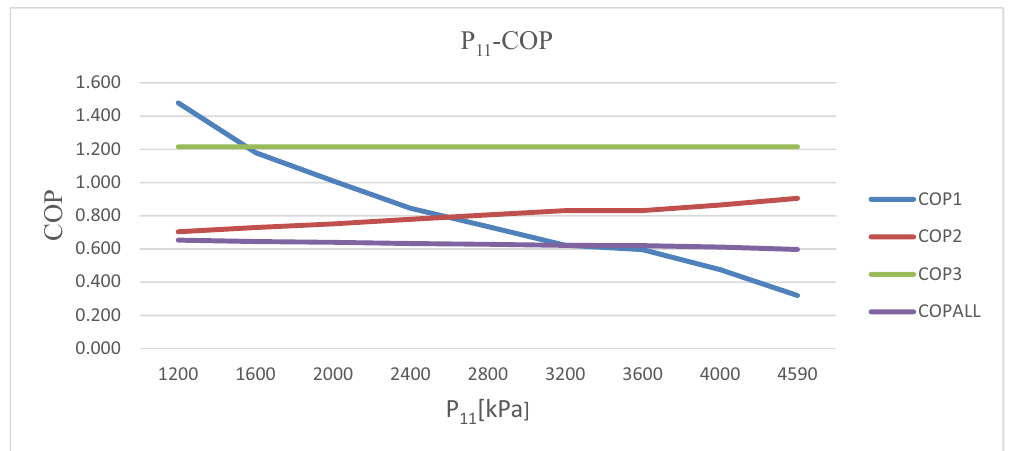
Figure 7: COP 1 , COP 2 , COP 3 , and COP all curves of the whole cycle obtained for di ff erent outlet pressures at which the fi rst - stage compressor of the vapor compression three - stage cascade cryogenic cycle can